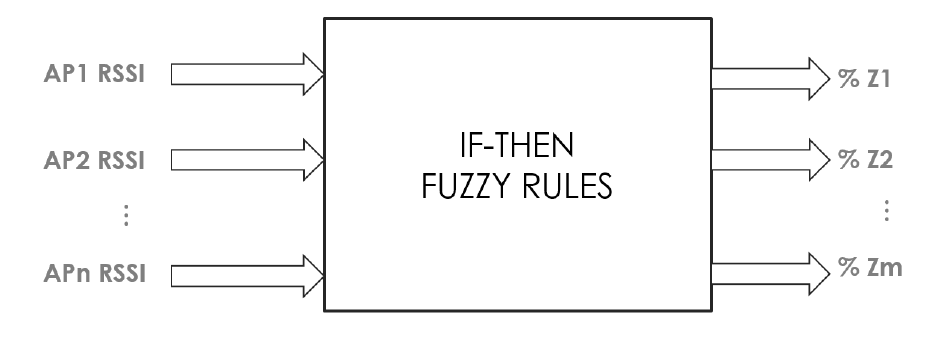
Figure 11. FIS mapping inputs to outputs for